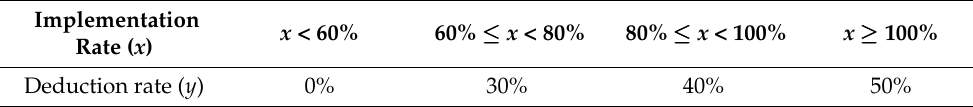
Table 4. The relationship between x and y in 2-h daily reduction